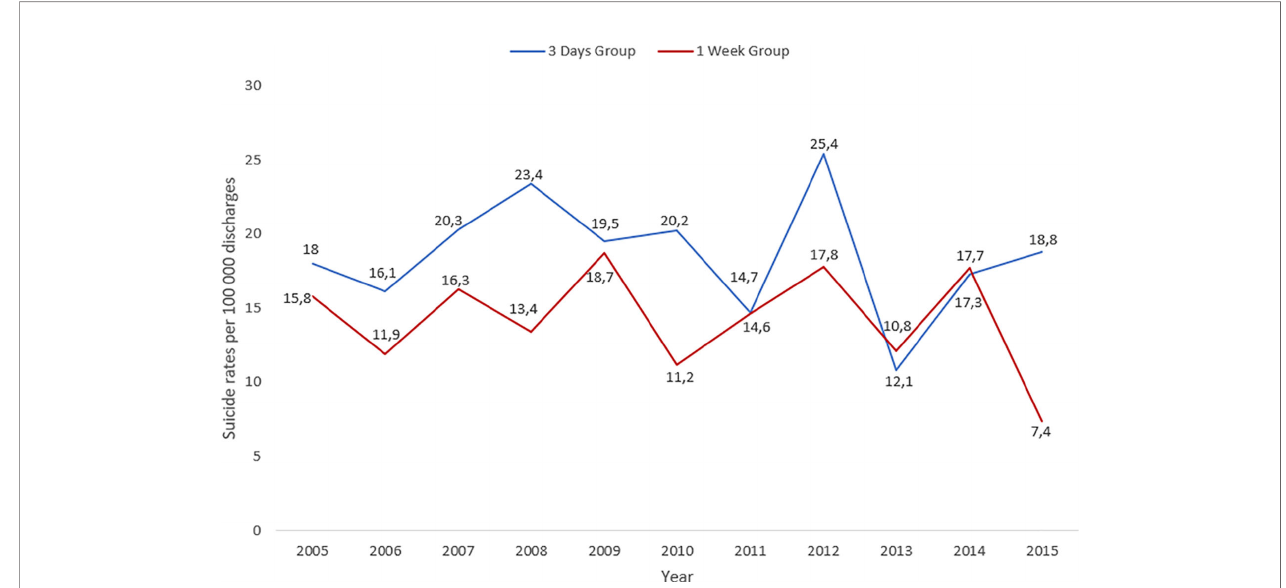
FIGURE 3 | Rates of suicide per 100,000 discharges from psychiatric in-patient care per year in England and Wales between 1st January 1997 until 31st December 2015 for 3 d and 1 week group.